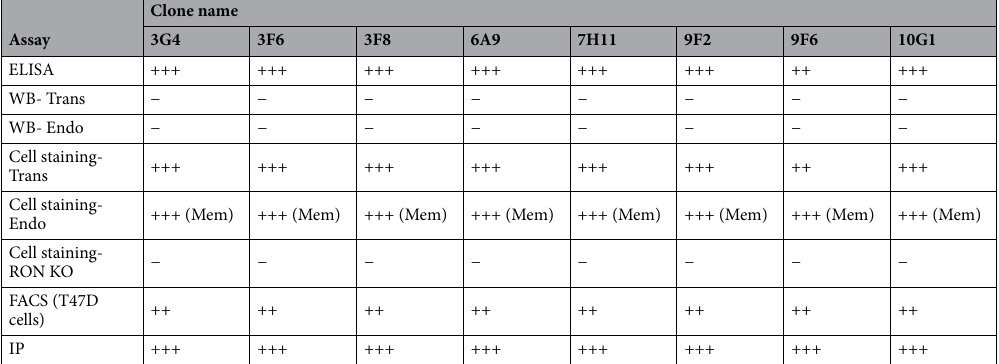
Table 1. Summary table showing the characterization of anti-RON antibodies by binding assays. Trans stands for transfected cells, Endo stands for endogenous RON expressing cells, RON KO stands for RON knock-out cell HCT116 cells. Mem indicates membrane staining. IP stands for immunoprecipitation.